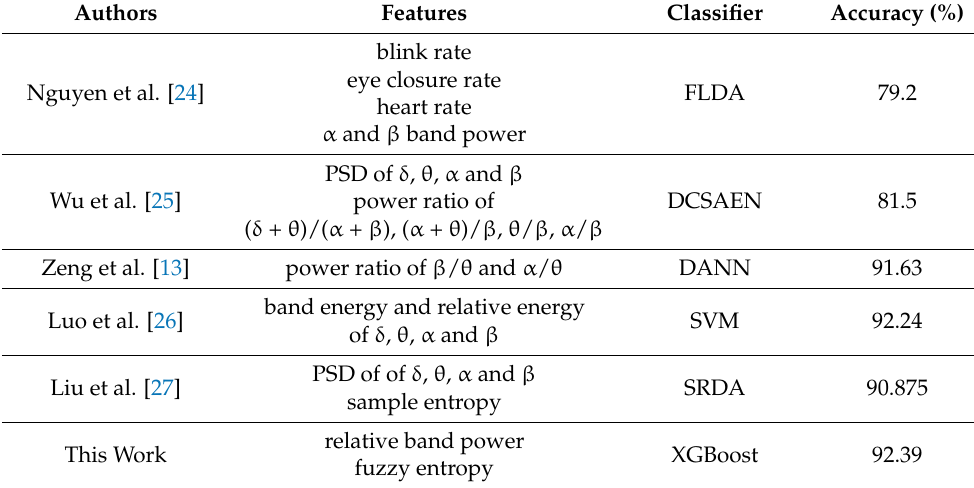
Table 5. Comparison of Existing